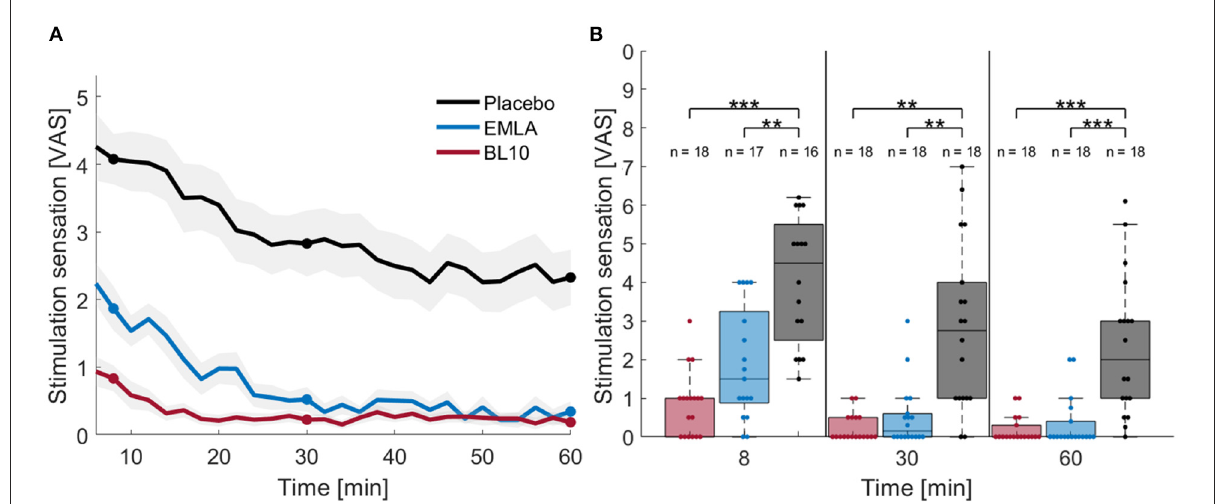
FIGURE3 Effect of topical anesthetic gels on tDCS stimulation sensation. (A) The mean stimulation sensations in time for the BL10 gel (red), EMLA (blue) and placebo gel (black), with confidence intervals shown in gray. Subjects indicated significantly higher stimulation sensations for the placebo gel, compared to the gels containing anesthetics. (B) The results of the post-hoc analysis at the three timepoints 8, 30 and 60min after gel application indicated significant differences between the gels containing anesthetics compared to placebo with ** p < 0.01, *** p <